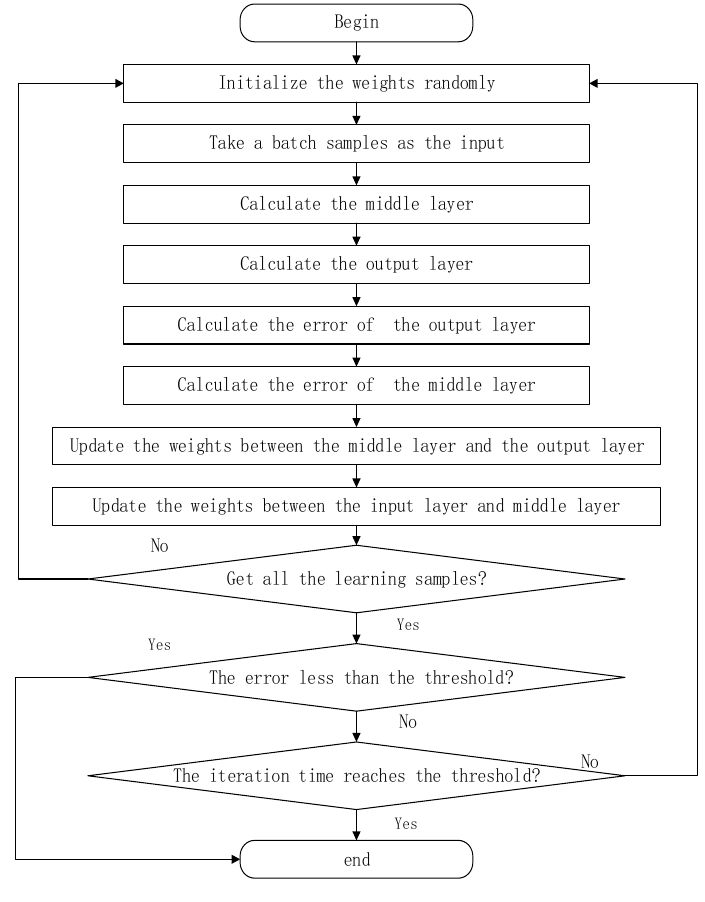
Figure 2. Process of model Figure 2. P rocess of model training.